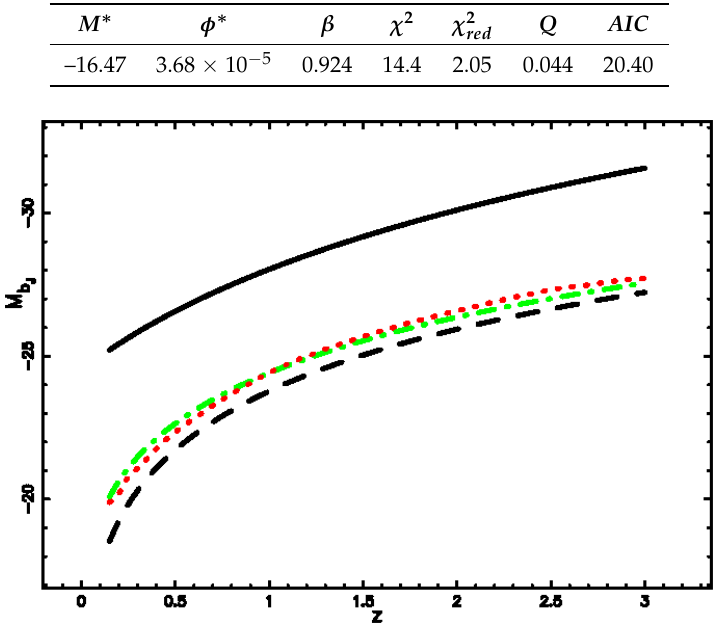
Table 4. Parameters of the Pei LF in the range of redshifts [ 0.3,0.5 ] with k = 3 and n = 10.